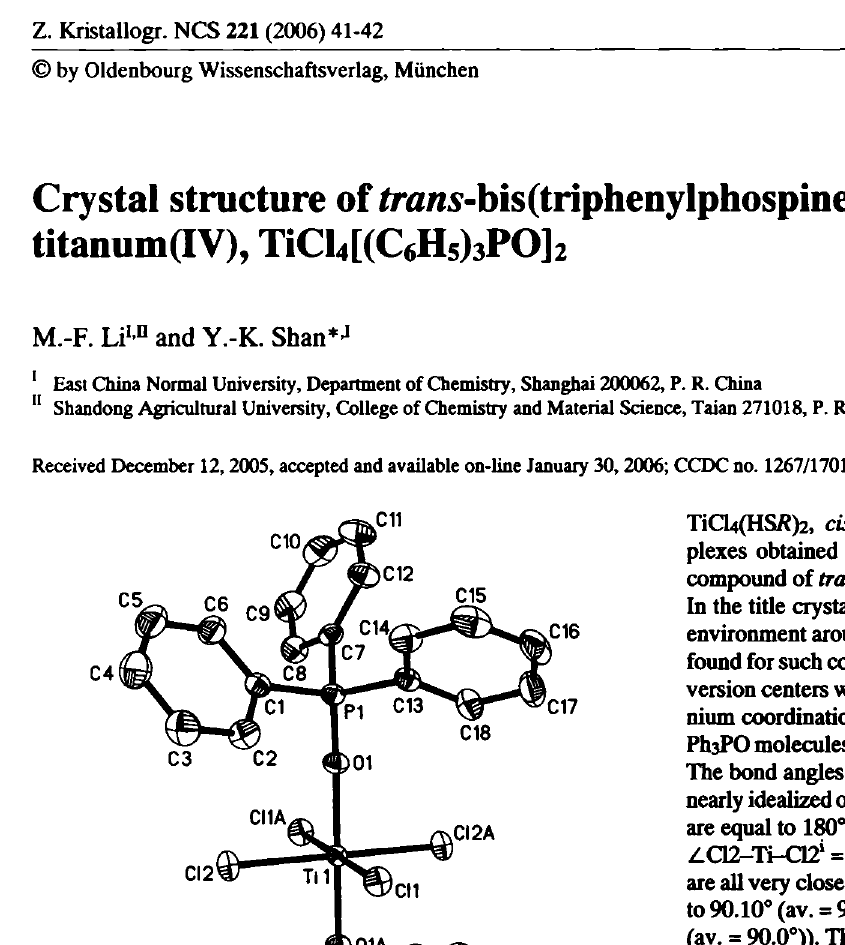
Table 1. Data collection and handling.